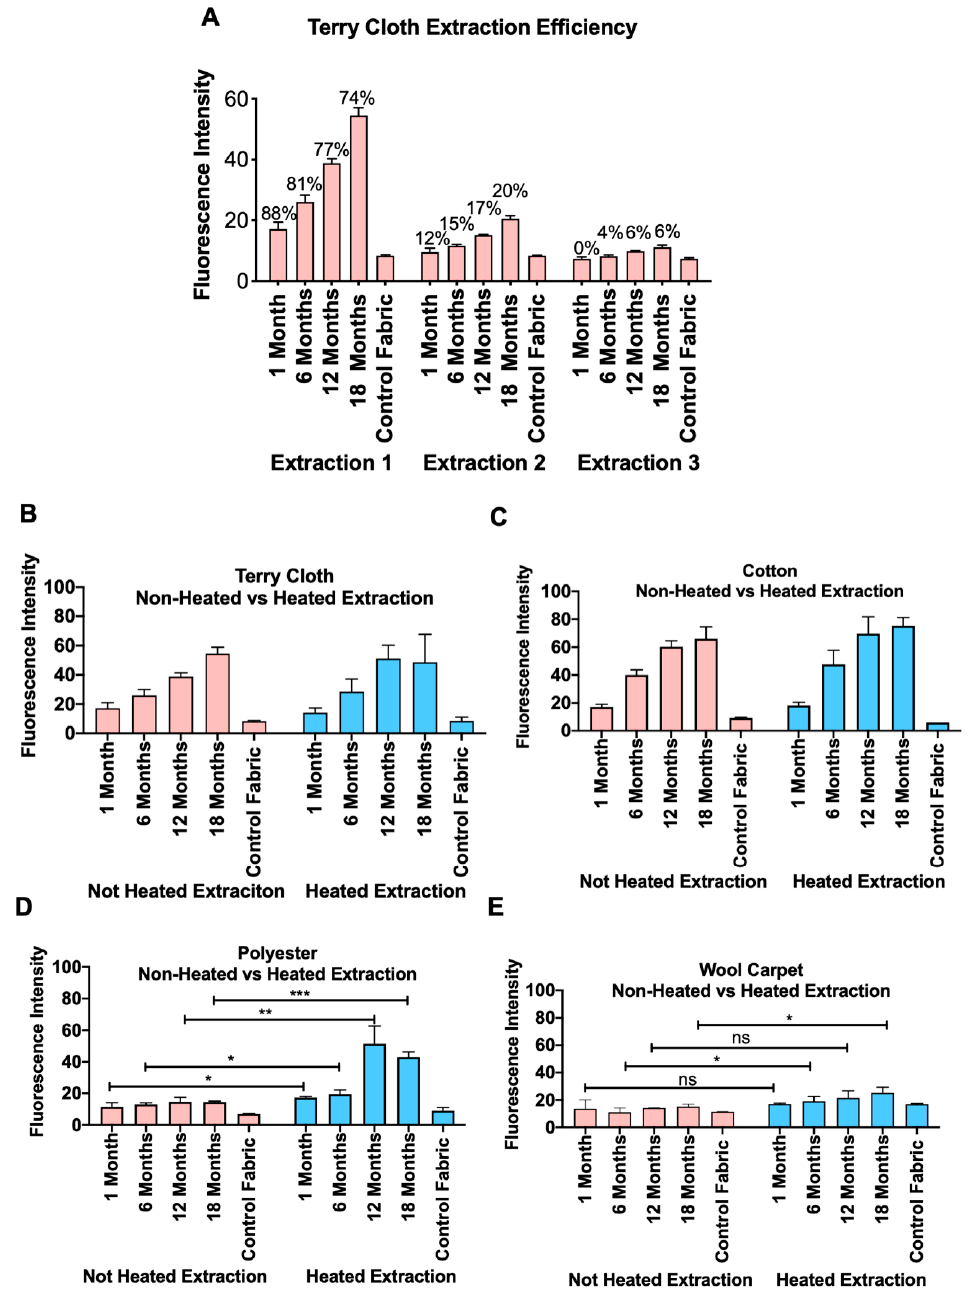
Figure 3. Effect of multiple extractions and heating on extraction efficiency as measured using autofluorescence. ( A ) Most of the residue was removed in the first of three extractions. ( B – E ) Extraction was improved in some fabrics by heating for 1 h at 60 °C. (* p < 0.05, ** p < 0.01, *** p < 0.001).